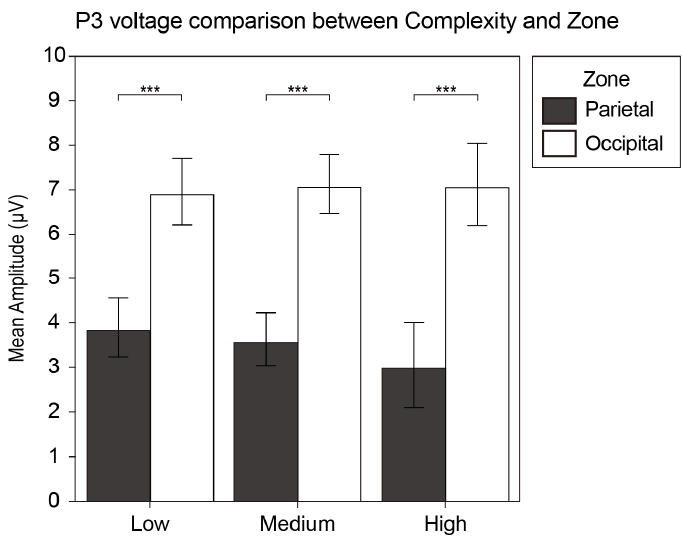
Figure 6. Bar plots of the interaction effect of the P3 component. Values plotted are means ± standard errors. Stars indicate significance levels: *** = p < 0.001.